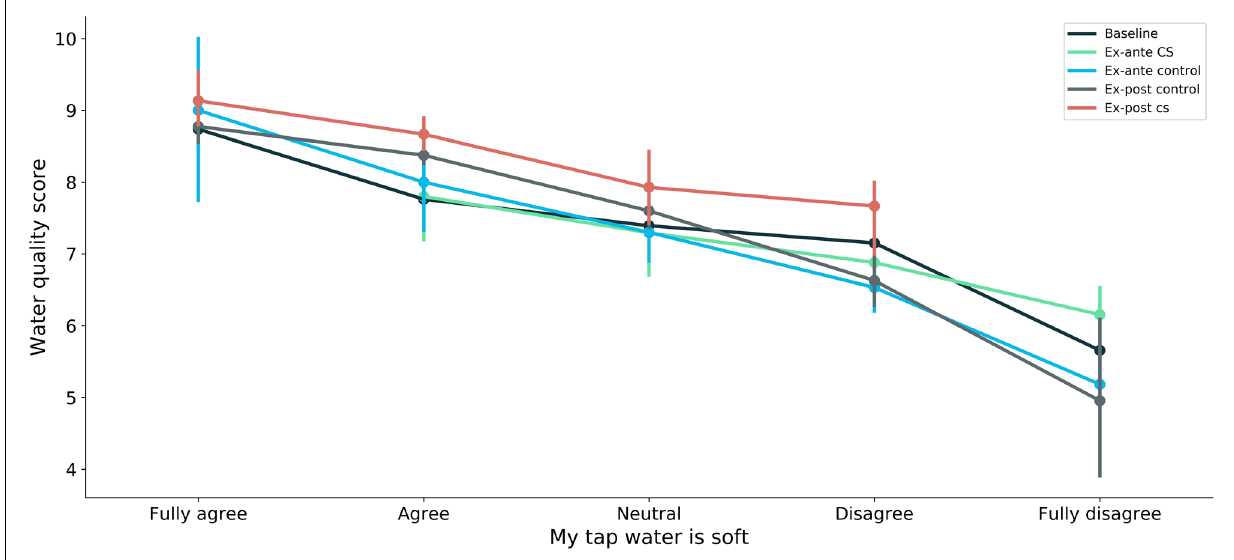
Figure 6 Correlation between the perceived hardness and the quality of water.